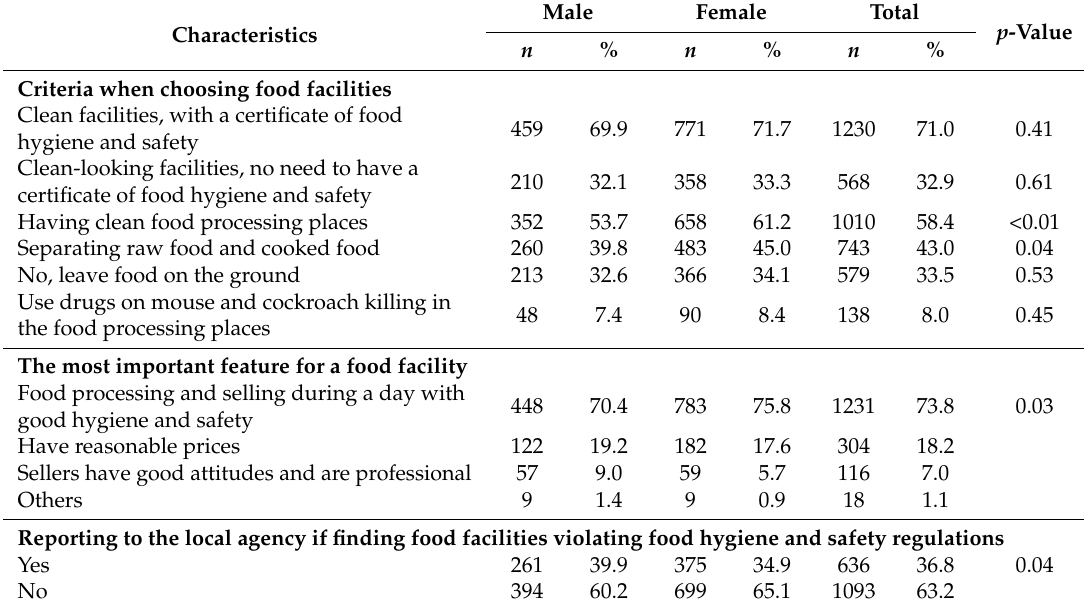
Table 3. Criteria when choosing food facilities among